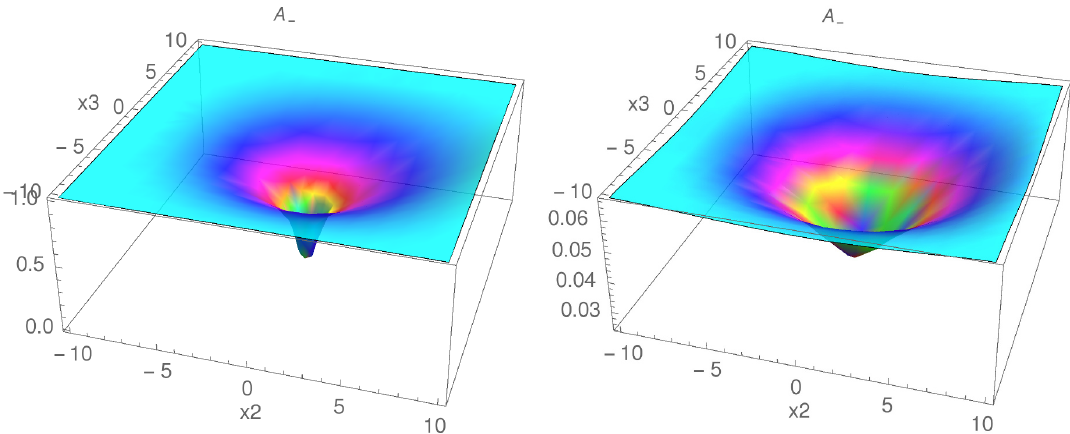
Figure 6 . Slices of the solution for A − at z = 0 (left) and z = 5 (right). For these plots we fixed N/ 16 π 2 κ = 1 and A − ( x 2 , x 3 , 0) = 1 at large | x 2 | , | x 3 | . The z = 0 slice is almost the same as in flat space. As z increases, the solution reduces in amplitude and eventually goes to zero at large z (as dictated by the boundary